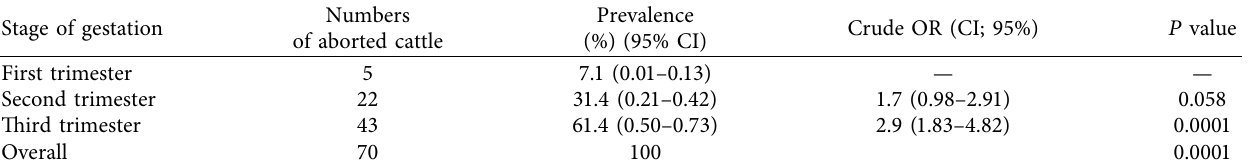
Table 4: Prevalence of abortion based on the stage of pregnancy.